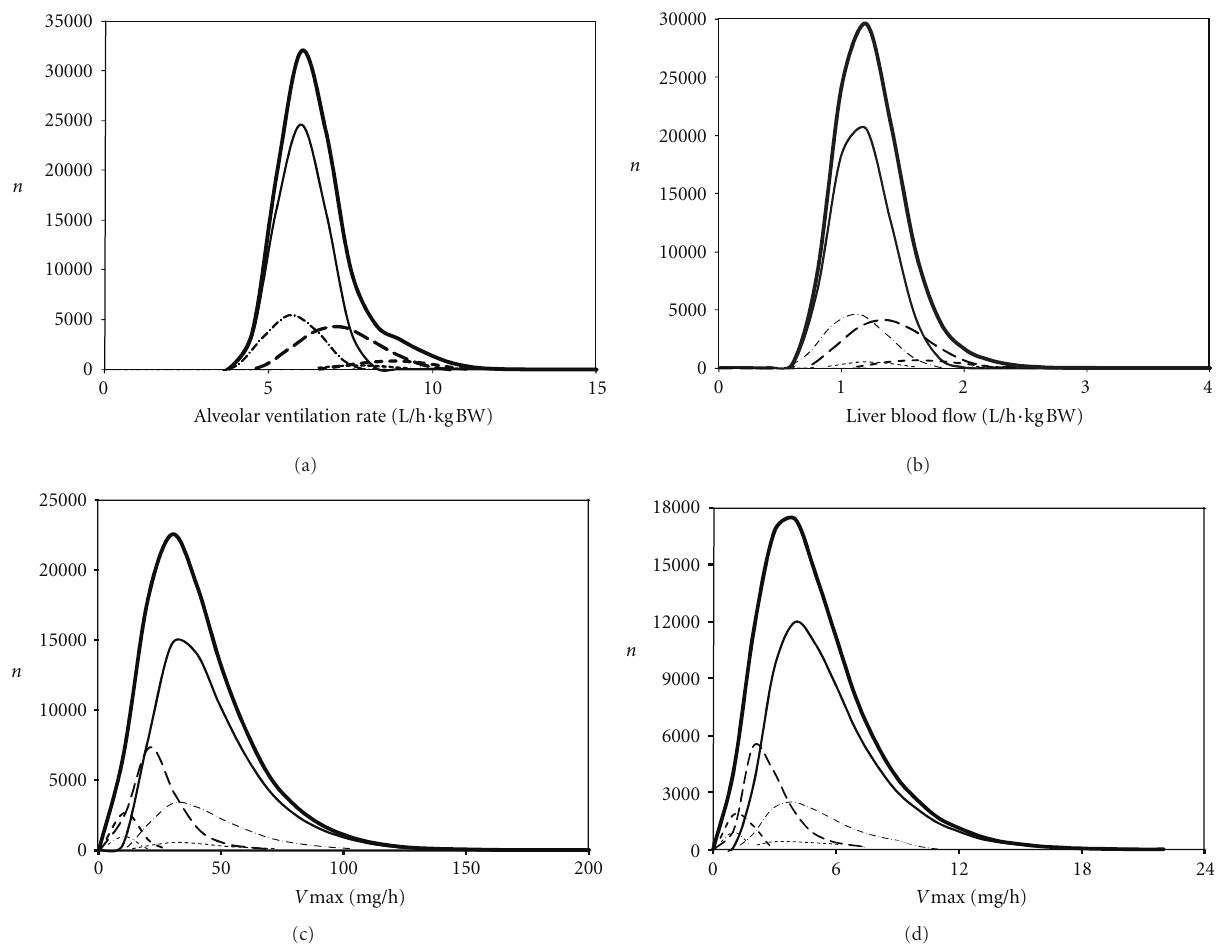
Figure 5: Distributions of individual values obtained for several physiological parameters in each subpopulation within the whole virtual Canadian population. From top to bottom, distributions for body weight-adjusted alveolar ventilation rate (a), body weight-adjusted liver blood flow (b) and maximal rate of metabolism of benzene (c) and 1,4-dioxane (d) are shown for the entire Canadian population ( thick — ), adults (—), children and adolescents ( —– ), elderly (– · – · –), toddlers ( ––- ), pregnant women (-------), infants (- · - · - · -), and neonates